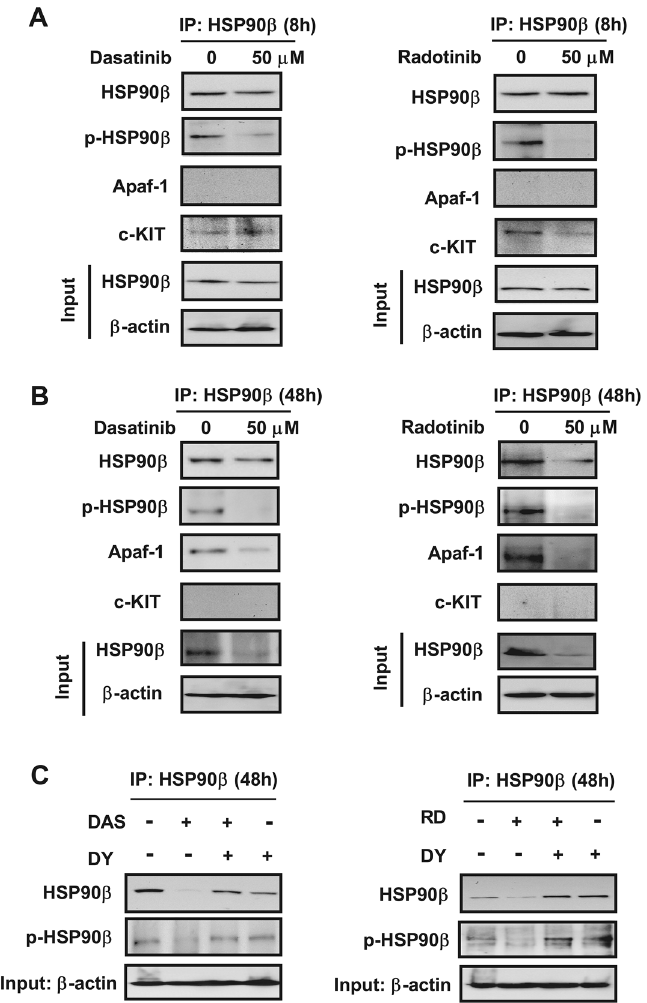
Figure 1. Corrected version of Figure 6.